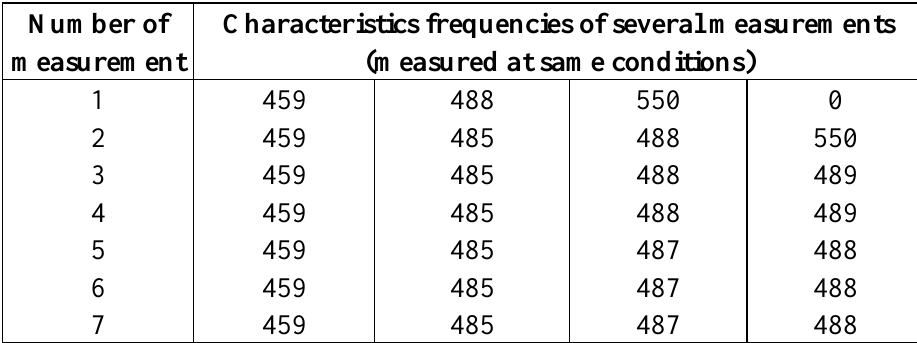
Table 2. Example of input data for teaching the neural network (seven measurements of one specific condition of examined